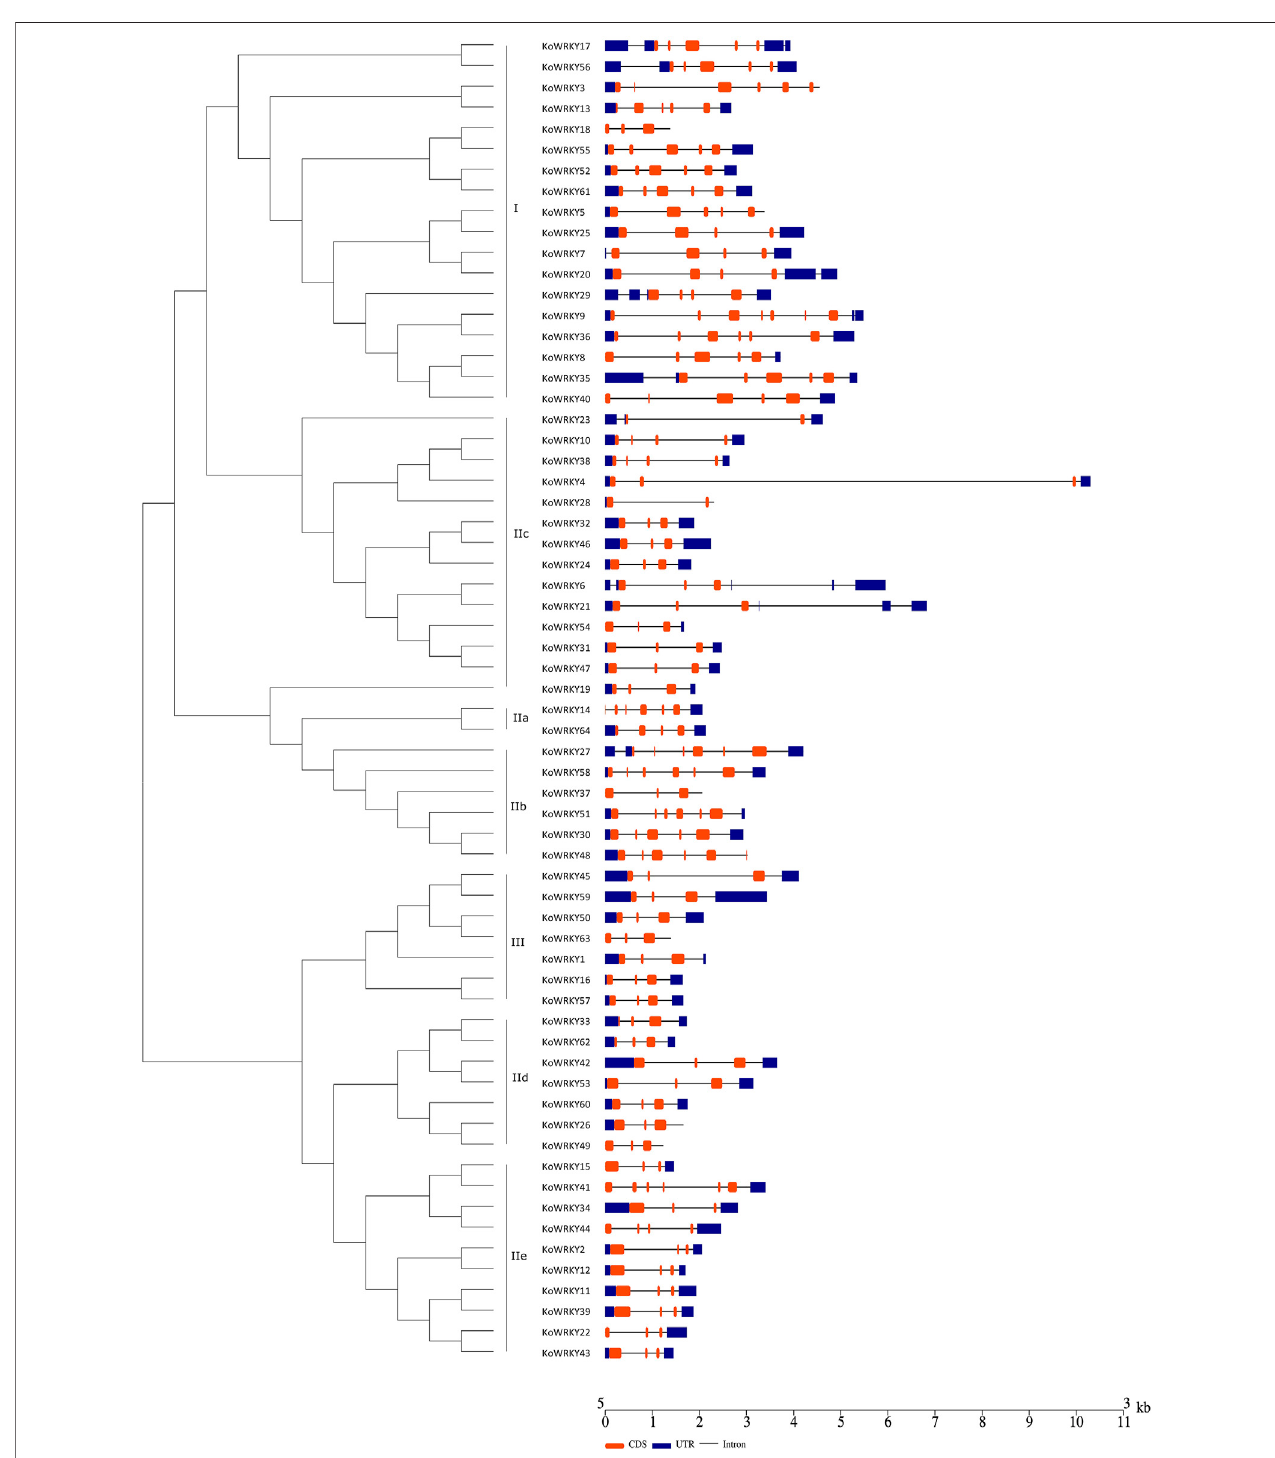
FIGURE2| Genestructureanalysisof KoWRKY genesfrom Kandeliaobovata .Exon – intronstructureanalysesofthe KoWRKY geneswereperformed via theGene Structure Display Server (GSDS) online tools. The lengths of the exons and introns of each KoWRKY gene are shown proportional to each other. The introns are represented by black lines, and the exonsand UTRs are represented by brown and blue boxes, respectively. A scale ofgene length isgiven at the bottom. CDS, coding DNA sequence; UTR, untranslated region.